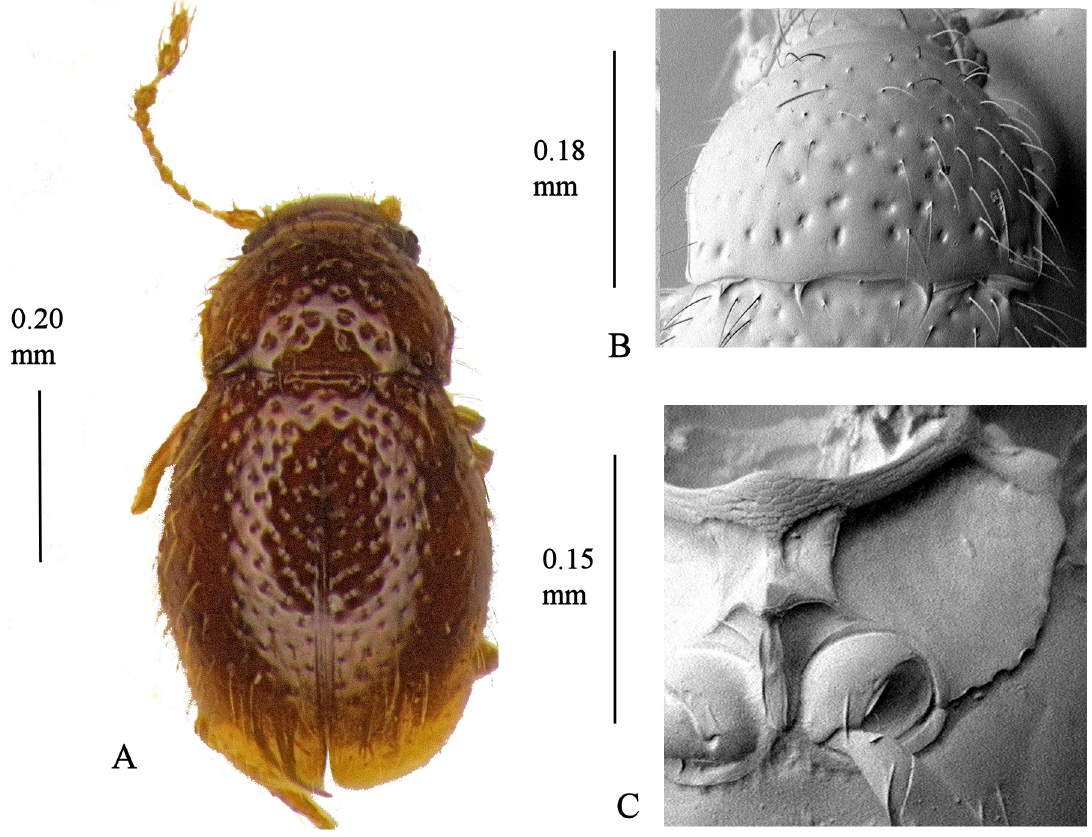
Fig. 112. Cissidium sakaii Sawada, 2008. A . Habitus. B . Pronotum, × 580. C . Mesoventrite showing median process of collar, mid-keel, keel and lateral margin,